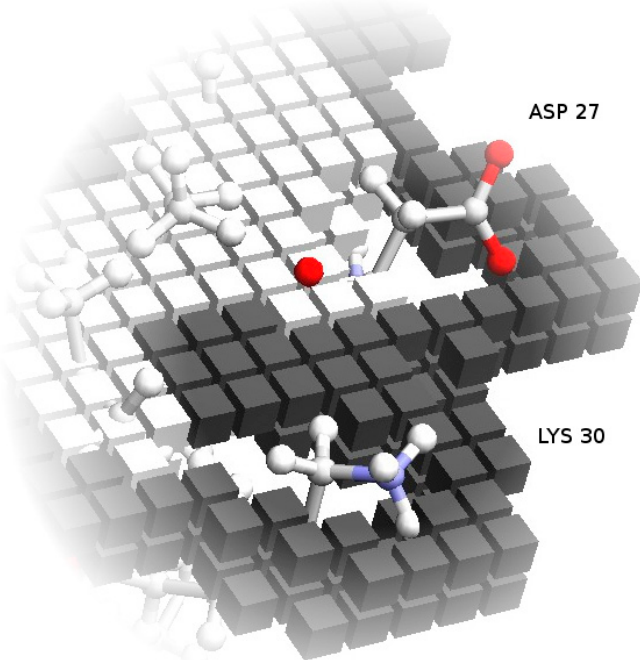
Figure 2. Soft docking grid. Using Annexin 24 monomer (PDB ID 1dk5) [38] as an example, this figure shows the core grid cells removed at the locations corresponding to the exposed side-chains of Asp27 and Lys30. Surface grid cells, represented in a darker color, still conform to the specific configuration of these residues in the PDB file. As an additional detail, note that the surface cells actually define an external shell of the protein shape. This is deliberate, so that the maximum overlap of surface cells from two grids corresponds to a realistic distance between the atoms from the two partners.